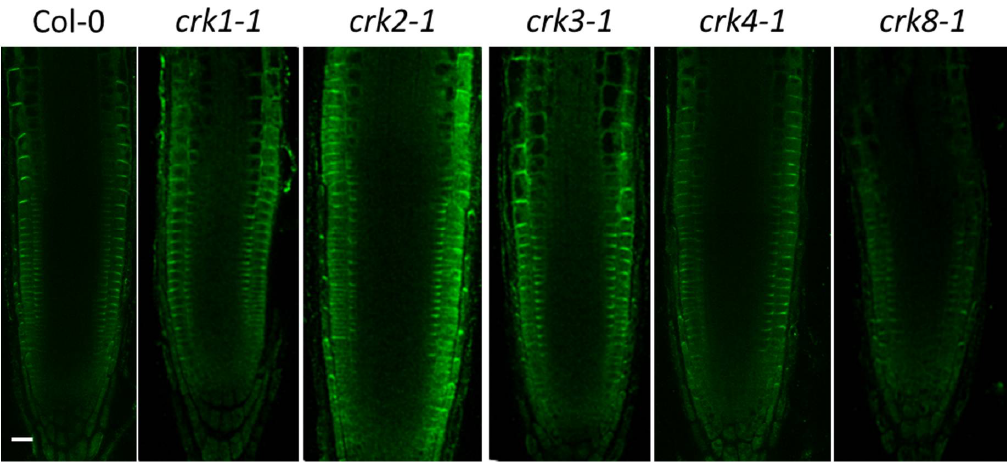
Figure 5. Immunolocalization of PIN2 in wild type Col-0 and the At crk mutants. PIN2 (green signal) shows normal localization in epidermal/cortex cells of Col-0 plants. PIN2 signal intensity or pattern is altered in most At crk mutants. Bar = 25 µm.